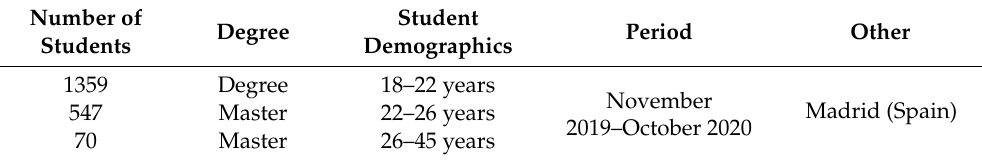
Table 4. Students